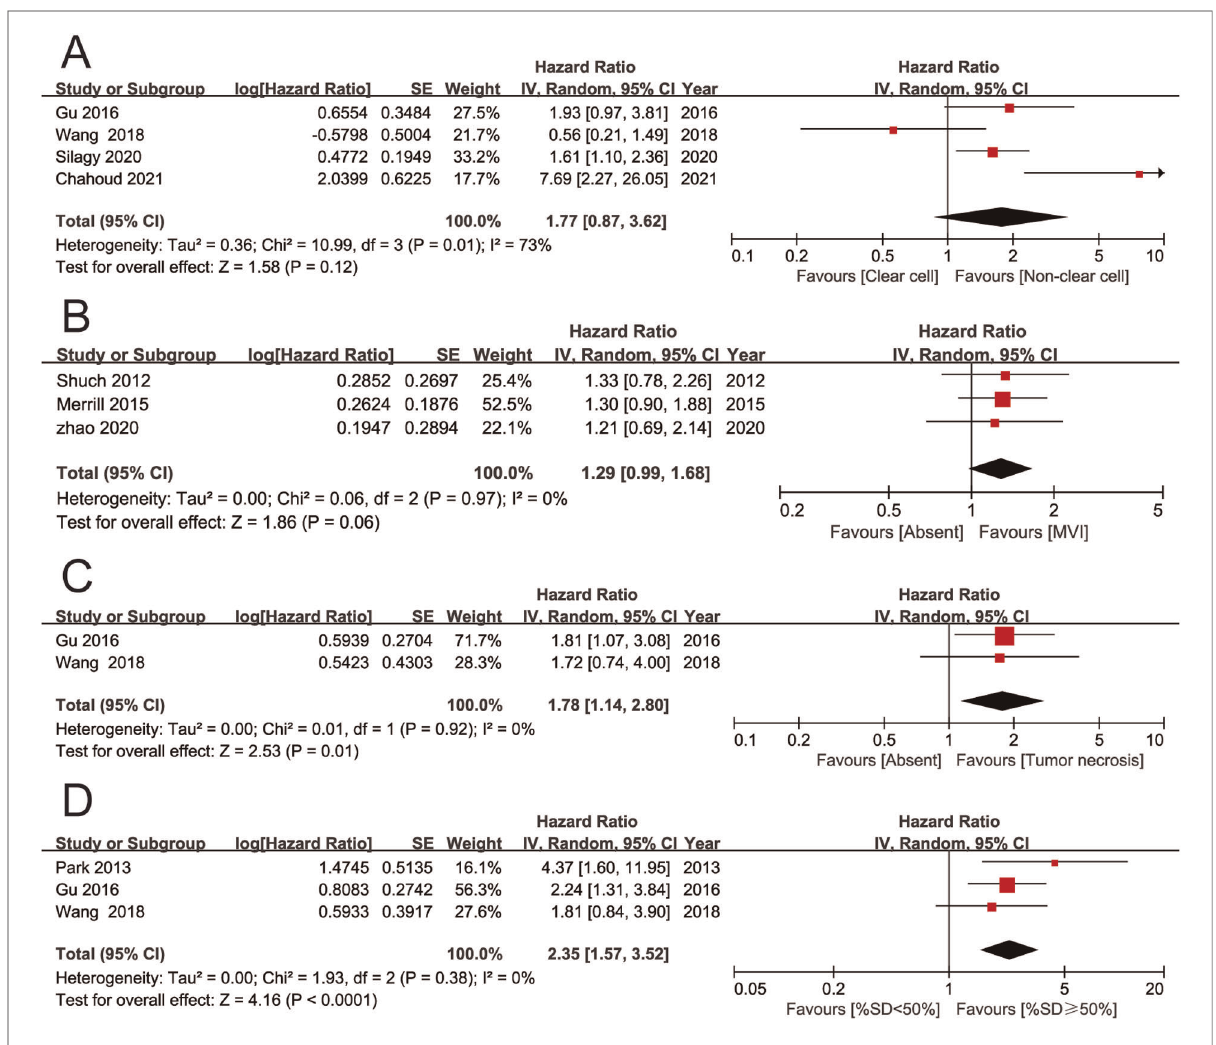
FIGURE 3 Forrest plots of meta-analyses of predictors of overall survival: ( A ) histology (non-clear cell vs clear cell); ( B ) microvascular invasion; ( C ) tumor necrosis; ( D ) percentage sarcomatoid ( ≥ 50% vs